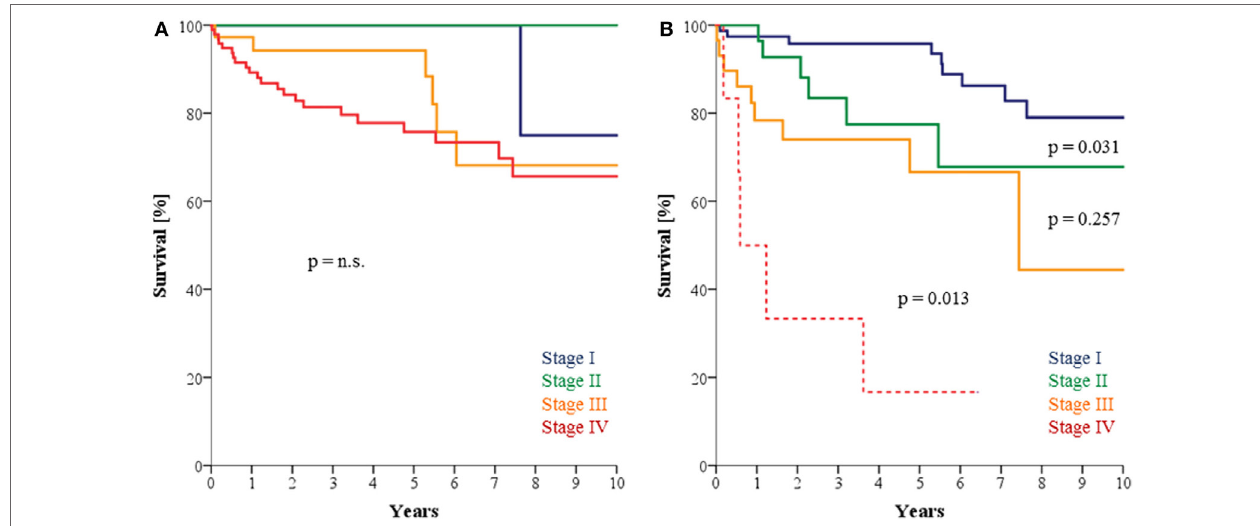
FiGUre 2 | (a) Survival of patients with human papilloma virus (HPV)-associated oropharyngeal squamous cell carcinoma (OPSCC) according to UICC 7th edition which presents with poor discriminative power between stages. (B) Survival of patients with HPV-associated OPSCC according to UICC 8th edition with significant discriminative power between stages I vs. II and III vs. IV but not between stages II vs. III. patients with HPV-associated OPSCC. Additionally, different The TNM criteria have been revised in the 8th edition of criteria for UICC stages in surgically and CRT-treated patients UICC according to a large patient cohort ( n = 1.907 patients exist according to treatment modality. with HPV-associated carcinoma) mainly treated with